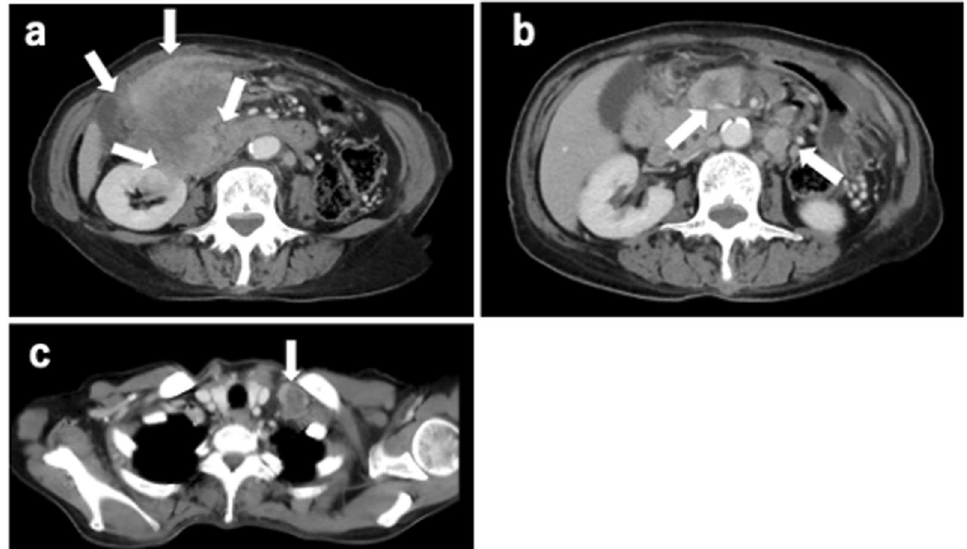
Fig. 1 Computed tomography scan. a A tumor in the right transverse colon, directly invading the right kidney. b , c Swelling of the periaortic ( b ) and left supraclavicular lymph nodes ( c )